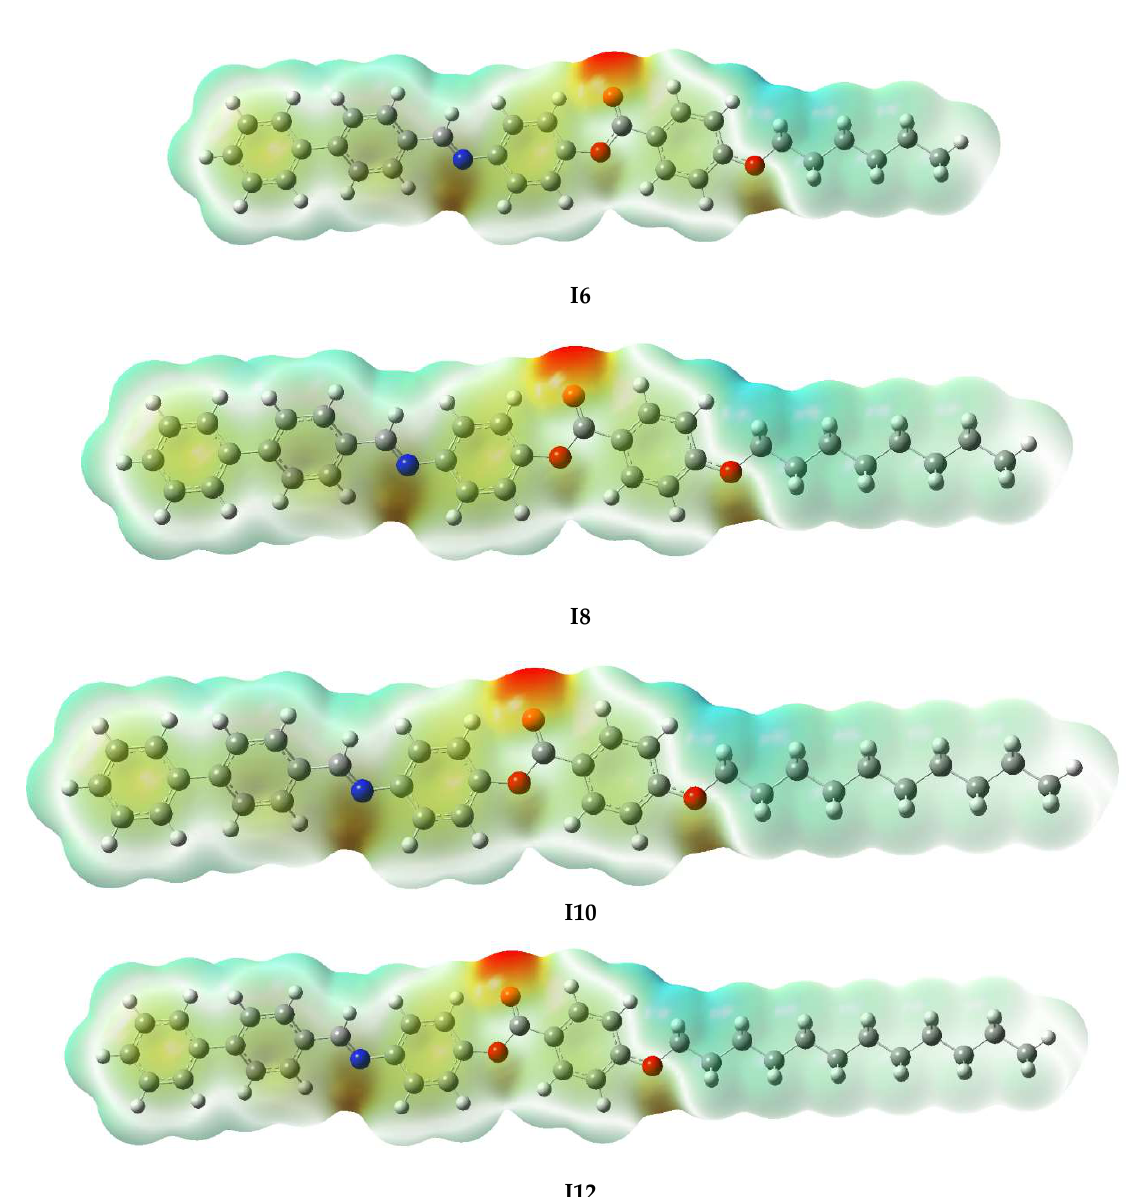
Figure 7. The molecular electrostatic potentials of the prepared I6 , I8 , I10 , and I12.